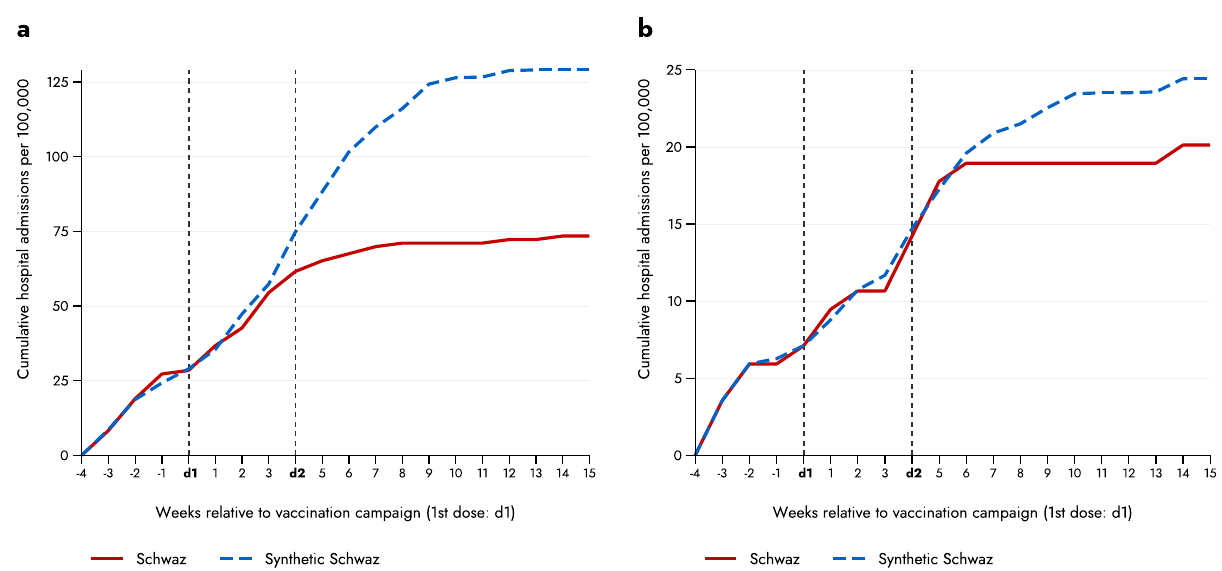
Fig. 3 Hospital and intensive care unit (ICU) admissions in Schwaz versus synthetic control group. The fi gure shows the cumulative weekly hospital admissions (per 100,000) related to a con fi rmed SARS-CoV-2 infection for Schwaz and the synthetic control group. ( a ) relates to general hospital admissions, and ( b ) to the ones in intensive care units (ICUs). The chose donors include Grieskirchen (15.8%), Reutte (61.9%) and Wiener Neustadt Land (22.3%) in the case of general hospital admissions, and Bregenz (7.8%), Bruck-Mürzuschlag (20.5%), Hermagor (11.3%), Neusiedl am See (51.5%) and St. Pölten (8.9%) for ICU admissions. The horizontal axis shows the number of weeks relative to vaccination campaign (dose 1). The pre-treatment period started four weeks before the fi rst dose, the post-treatment period ended 15 weeks after the fi rst dose. The vertical dashed lines represent the fi rst dose (d1) and the second dose (d2) administered as part of the mass vaccination campaign.